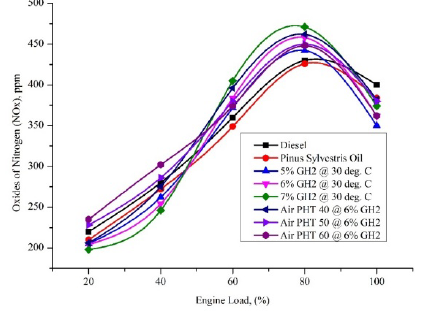
Figure 5 NOx Vs. Engine